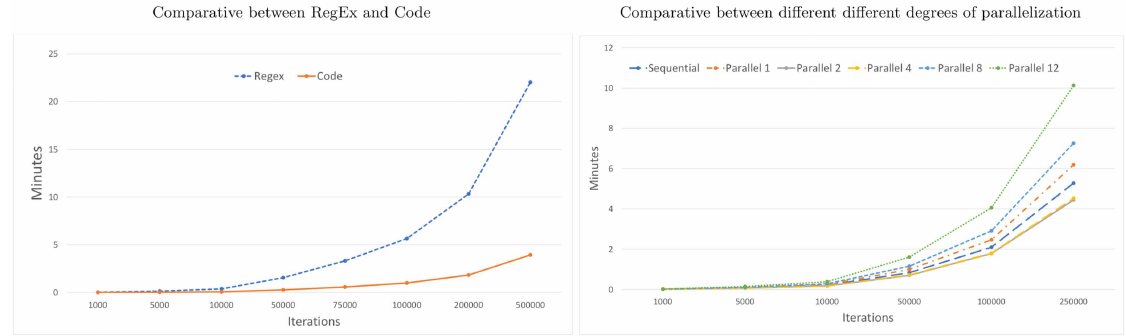
Figure 16. Computation